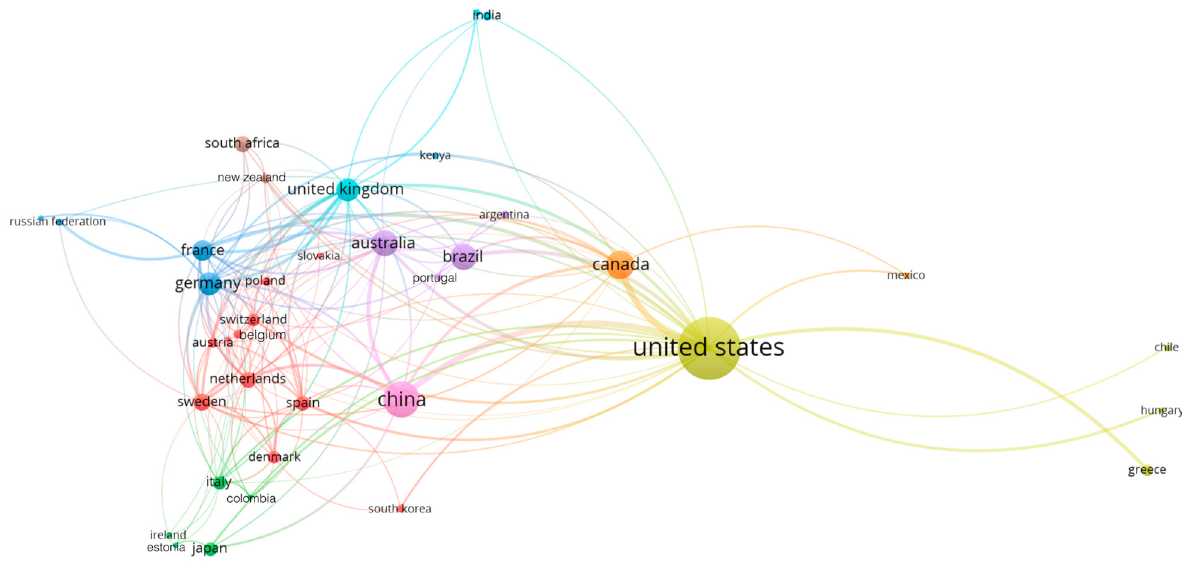
Figure 5. Co-authorship network of the countries publishing on riparian zones. A threshold of 5 published documents was applied, resulting in a total of 32 countries. The bubble size refers to the total number of publications. Line thickness and color refer to link strength and clustering, respectively.